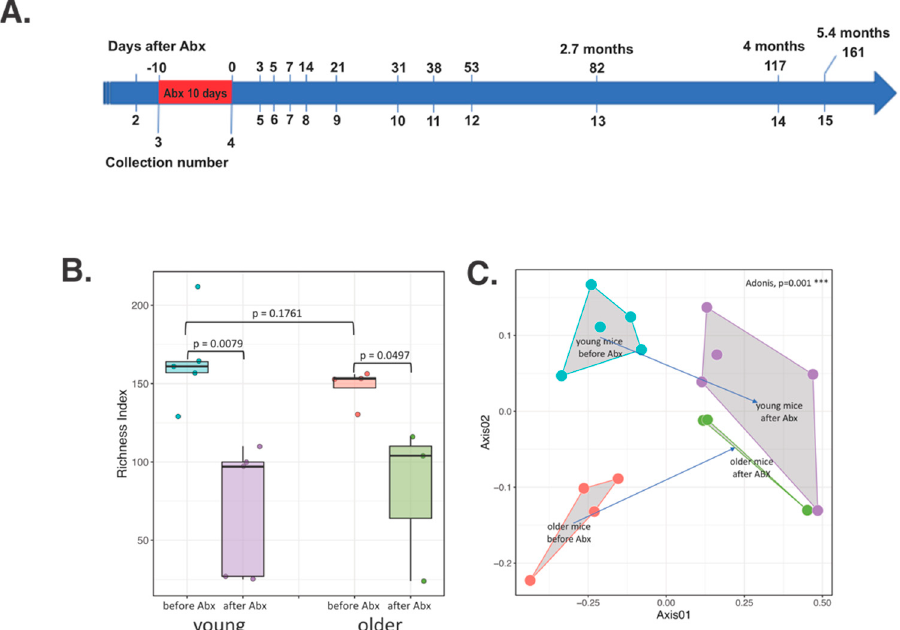
Figure 1. ( A ) Sampling and antibiotic treatment schematic for 6 months. All of the mice were treated with the antibiotic cocktail for 10 days (red) and stool samples were collected as shown by the collection numbers. The numbers above the time scale depict the day since the antibiotic treatment, whereas the corresponding collection number below depict when the samples were collected. ( B ) Box plot of amplicon sequence variant (ASV) richness in young and older mice before and after 10 days of antibiotic treatment. Points represent the ASV richness of each mouse gut microbiota sample. P -values were calculated with the Mann-Whitney test. ( C ) Bray-Curtis based non-metric multidimensional scaling (NMDS) plot of distances between young and older mice before and after antibiotic treatment.